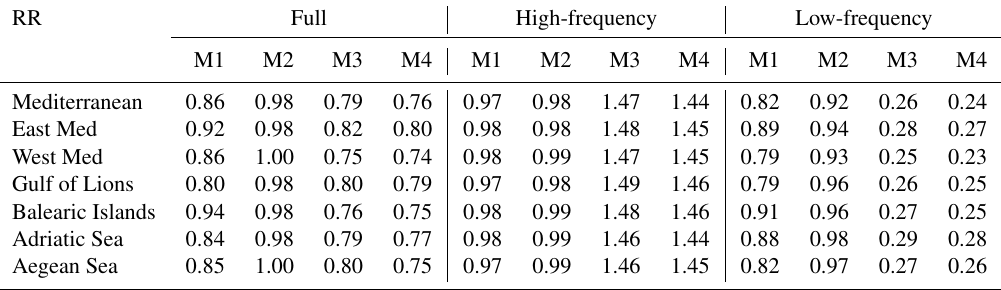
Table 2. Same as Table 1 but for the RMEDSE ratio. RR Full